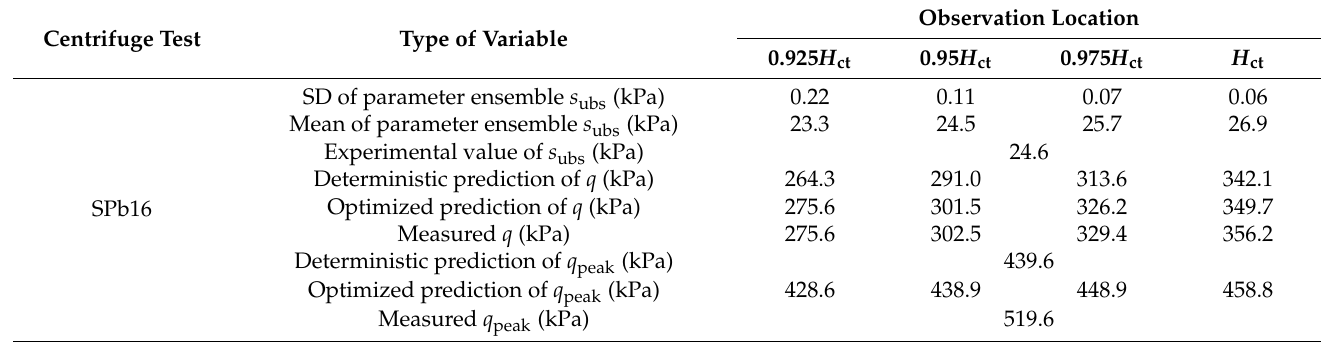
Table 5. Variations of data during the process of parameter optimization for Test SPb16.